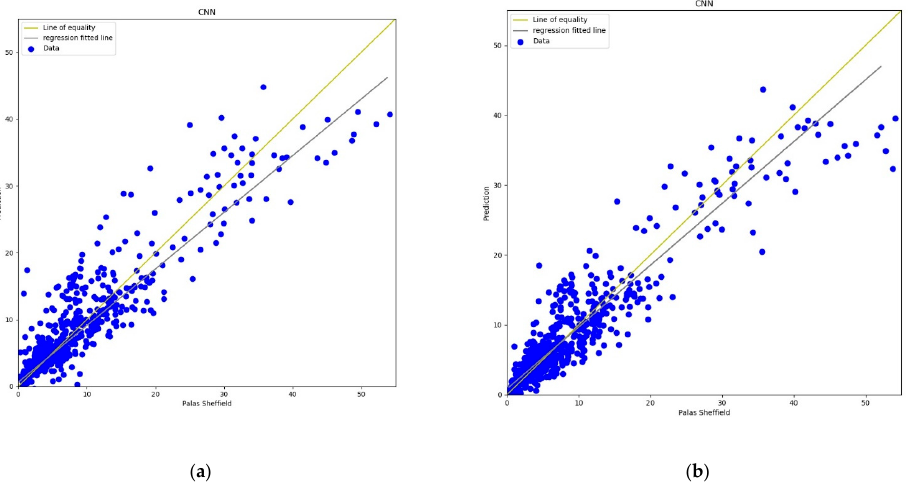
Figure 14. ( a ) CNN calibration scatter plot for PM 2.5 with the line of equality, regression fitted line, and the calibrated data using AH ; ( b ) CNN calibration scatter plot for PM 2.5 with the line of equality, regression fitted line, and the calibrated data using RH .